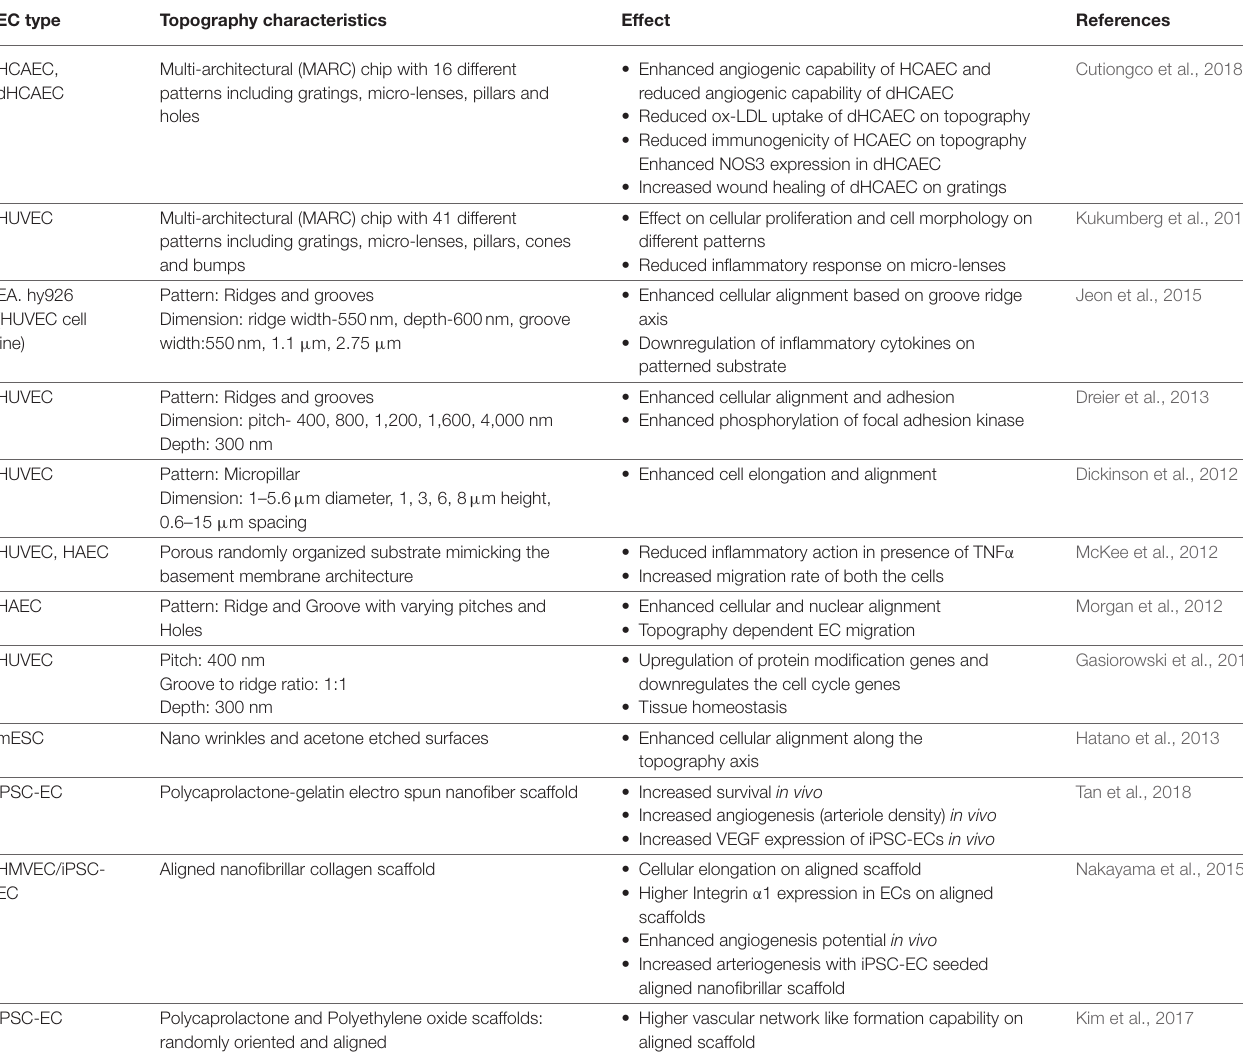
TABLE 3 | Effects of substrate topography on mature ECs and PSC-ECs phenotype and functions. EC